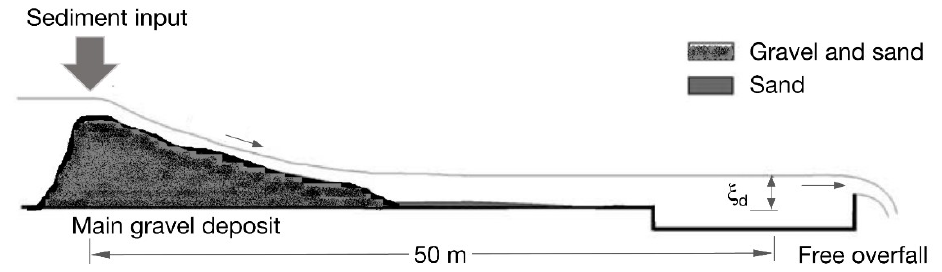
Figure 12. Flume set up for St. Anthony Falls Laboratory (SAFL) downstream fining experiments [15]. Table 4. Parameters for SAFL Downstream Fining Experiments; where: q w —water discharge, q s —sediment discharge, ξ d —downstream water depth, S 0 —flume slope, fs—sand fraction [15]. Exp. q w (m 2